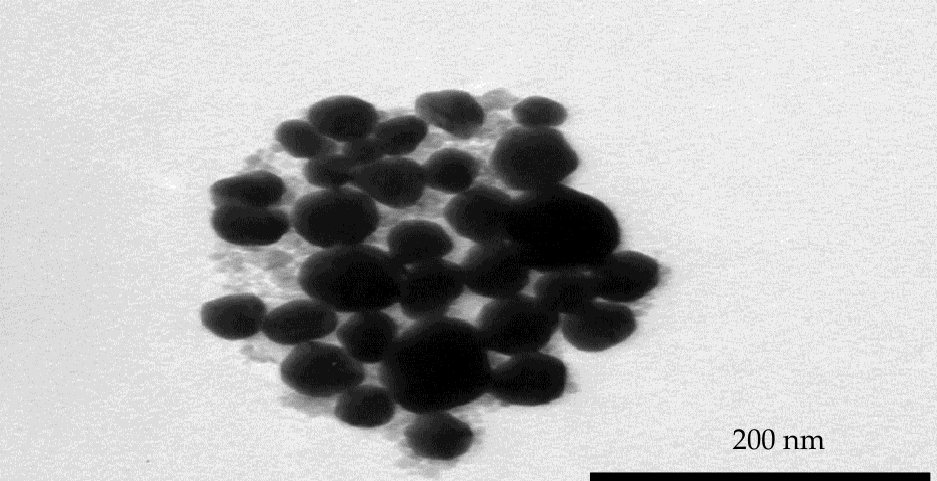
Figure 2. A TEM image of synthesized, magnetically purified, uncoated AuMNPs.